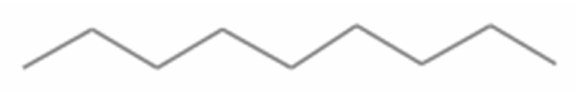
Figure 6. Chemical structure of nonane.